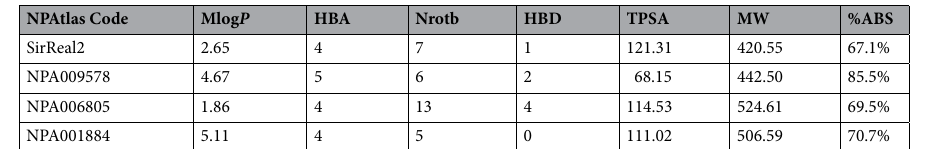
Table 4. Anticipated physiochemical characteristics of SirReal2 and the inspected NPAtlas compounds as promising SIRT2 inhibitors.